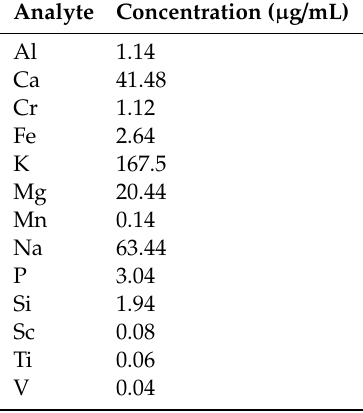
Table 1. Essential mineral components of human blood found during ICP-MS analysis of isolated extract from Justicia leaves.